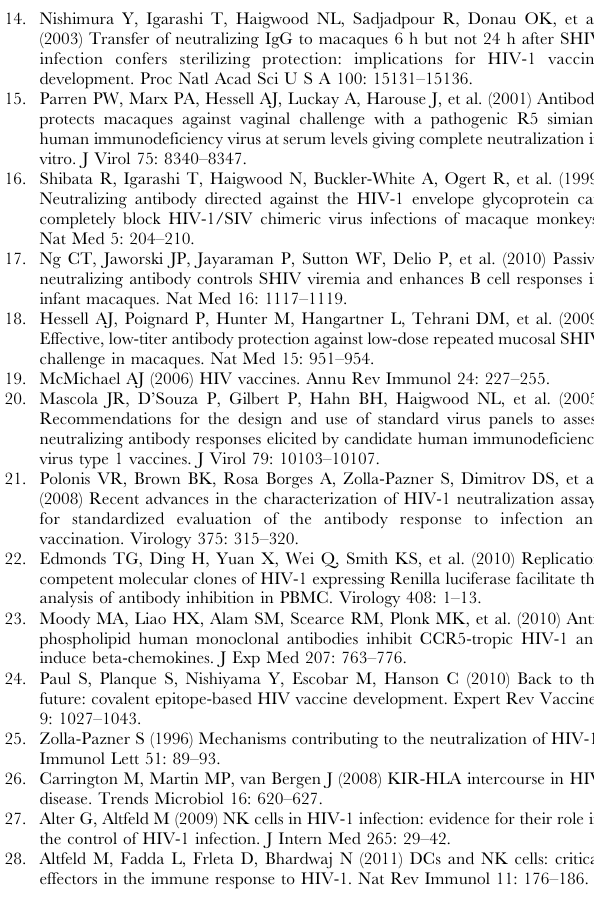
Figure S1 Gating strategy for enumerating cell popula- tions from bulk PBMC. The percentages of CD4 + T cells, CD8 + T cells, NK cells, B cells, and monocytes were quantified. Please see the materials and methods for more details. Figure S2 Rank values for viral permissivity (A) and neutralization (B). For viral permissivity (A), PBMC were given an individual rank value from 1 to 25 for each set of titers for each of 6 IMCs, with 1 assigned to the donor that supported the highest HIV-1 replication (high permissivity) and 25 assigned to the donor that supported the lowest replication (low permissivity). For each donor the individual rank values for each of the 6 IMC were then averaged to obtain the overall rank. Each single dot within a column represents the donors rank for a given IMC. The red